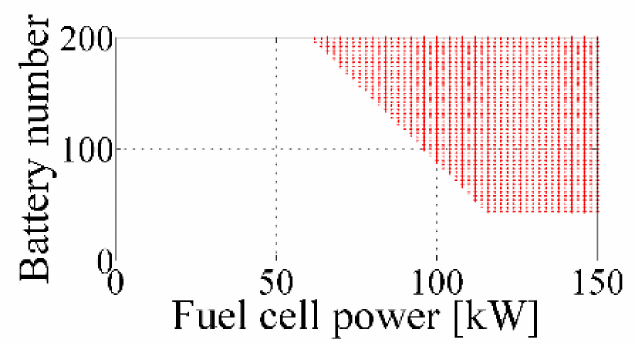
Figure 1. Power source sizing map.